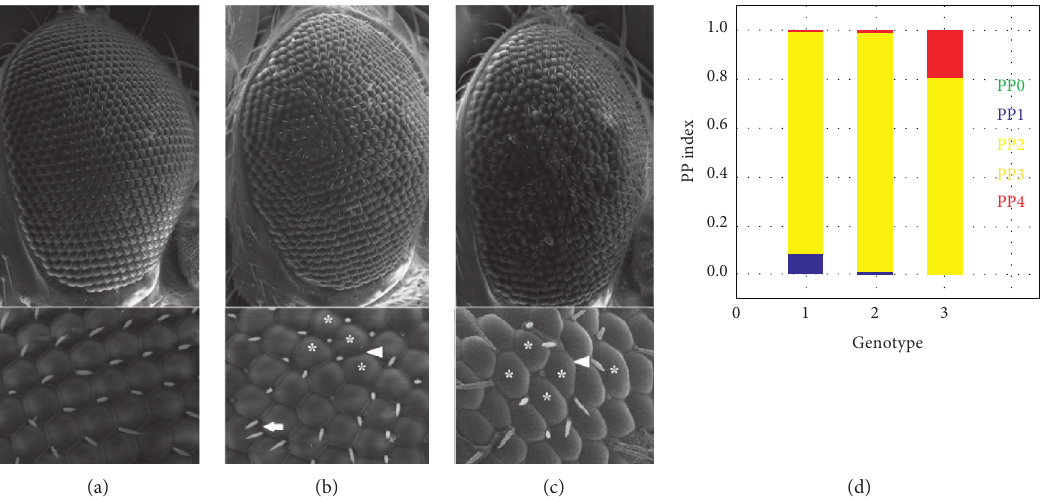
Figure 2: Overexpression of the E46K mutant human α -synuclein gene leads to the irregular surface morphology of the eye structures in transgenic flies. Scanning electron micrographs of ommatidial structures in GMR-Gal4::UAS-SNCA E46K flies show degeneration of retinal neurons which is evident by the irregular organization of ommatidia, extra and/or absence of bristles. (a) GMR/+ , (b) GMR/SNCA WT , and (c) GMR/SNCA E46K . ∗ indicate an irregular shape of ommatidium; the arrow represents the absence of bristle; and the arrowhead represents extra bristles. The ImageJ FLEYE tool illustrates a higher rate of ommatidial irregularity in SNCA E46K expressing flies (d) that accounts for more severe neuronal degeneration in SNCA E46K expressing flies compared to that seen in the SNCA WT (PPi � probability parameter for irregularity). Scale bar, 20 μ m. Five samples of each genotype were analyzed.